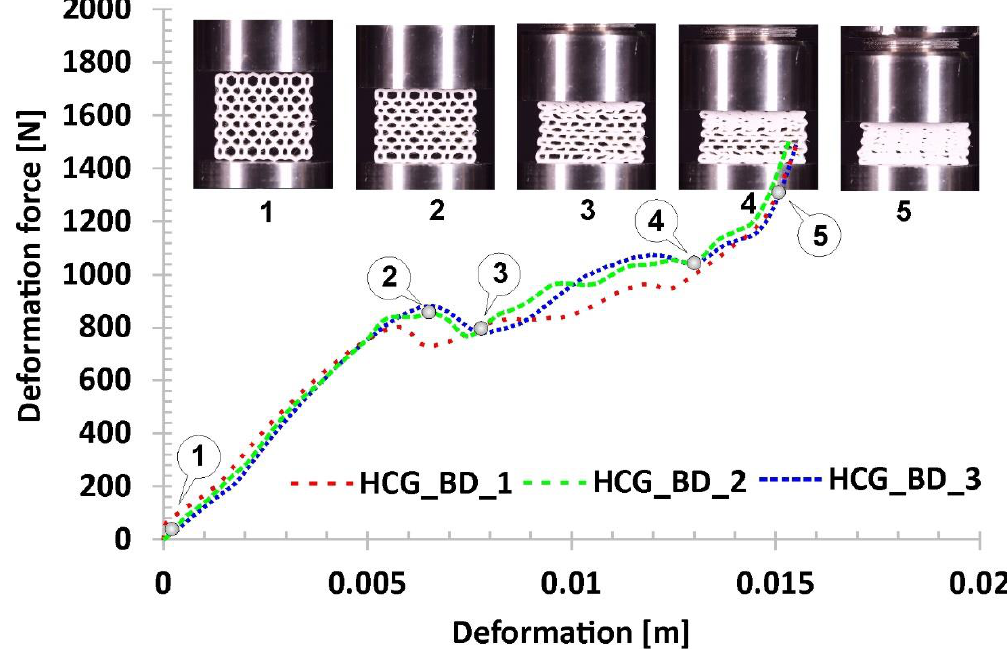
Figure 17. The results of the compression tests of the structural specimen with bidirectional gradual honeycomb topology. Polymers 2020 , 12 , x FOR PEER REVIEW